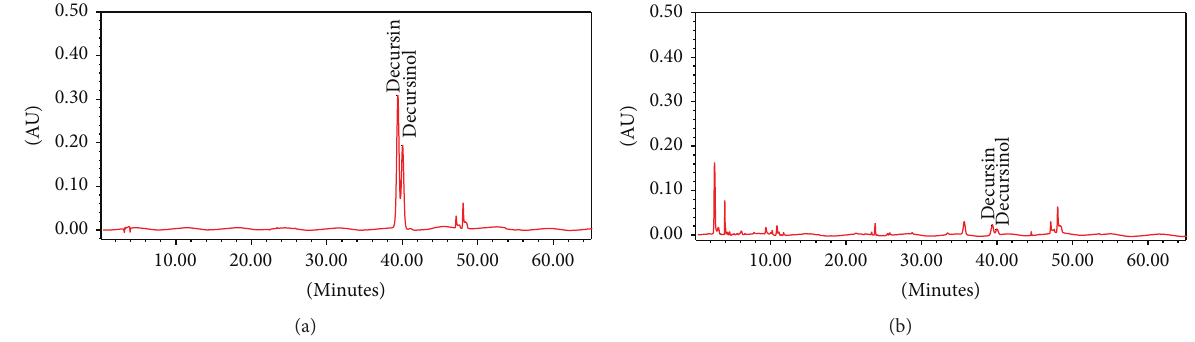
Figure 1: HPLC-PDA profiles of the index compound decursin, decursinol angelate, and the ethanol extract of AAK. Chromatograms of (a) decursin, decursinol angelate, and (b) AAK were monitored at 330 nm. Quantitative content of decursin and decursinol angelate in AAK was <